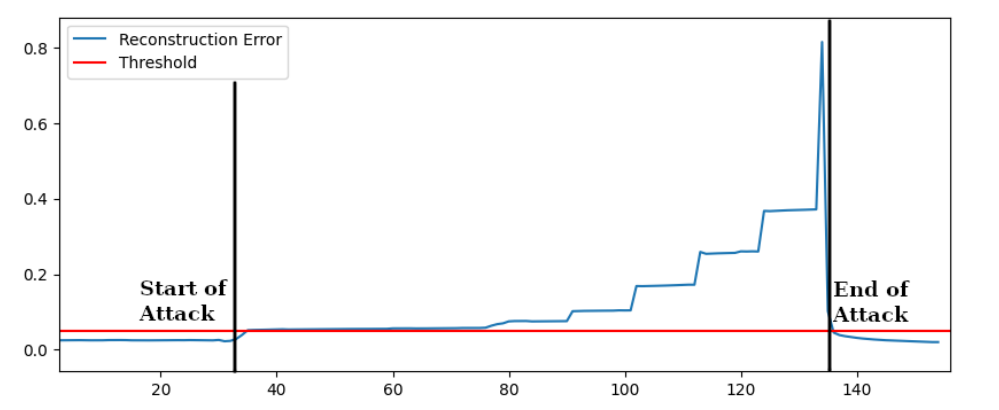
Figure 6. Reconstruction Error—Unsafe Power Injection.